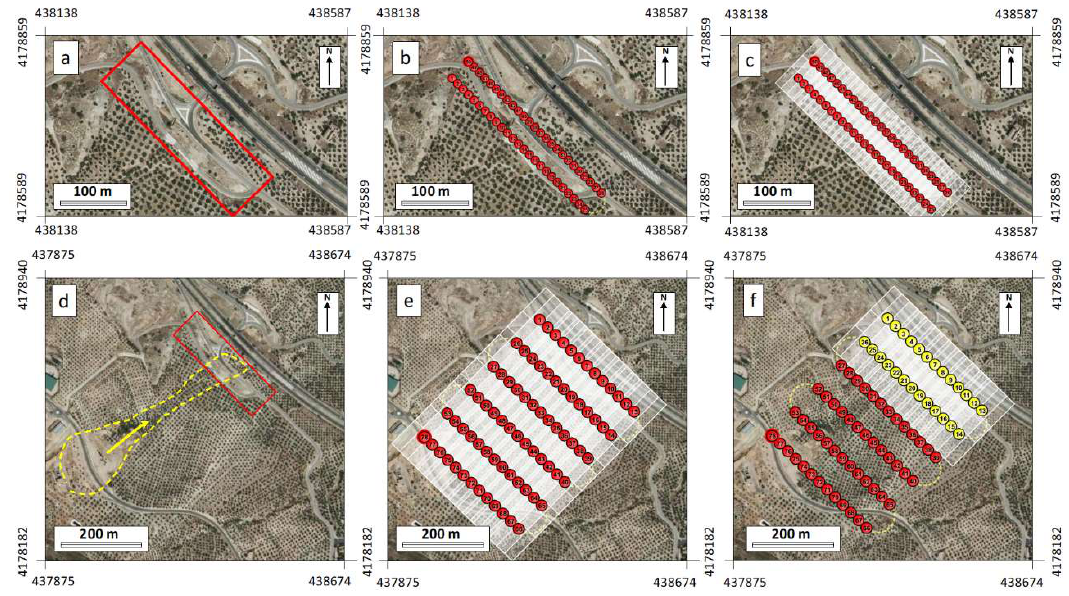
Figure 4. Landslide and affected roads. ( a ) surveyed area (red rectangle) on affected roads and access to highway at the landslide foot; ( b ) Mission planning and location of trigger points for the low height flights; ( c ) Mission planning and photo footprints of low height flights; ( d ) Main landslide affecting the slope (yellow dash line) and surveyed area (red rectangle); ( e ) Mission planning and location of trigger points for the general flights for the slope monitoring [42]; ( f ) photo footprints of the strips used in this paper from the general flights of the slope (19 November 2012; 16 July 2014). Coordinates are in ETRS89-UTM-30N.